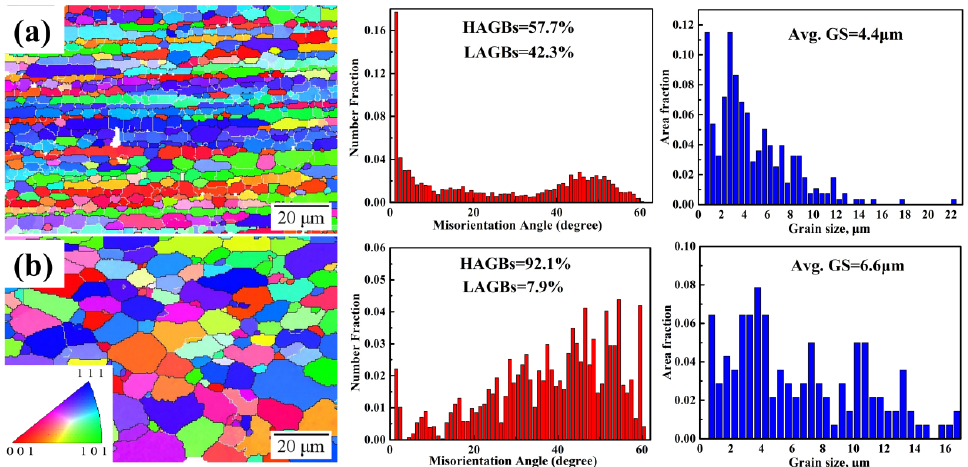
Figure 8. The microstructure of the tensile fractured sample with the engineering strain of 1180%: ( a ) grip section; ( b ) gauge section.